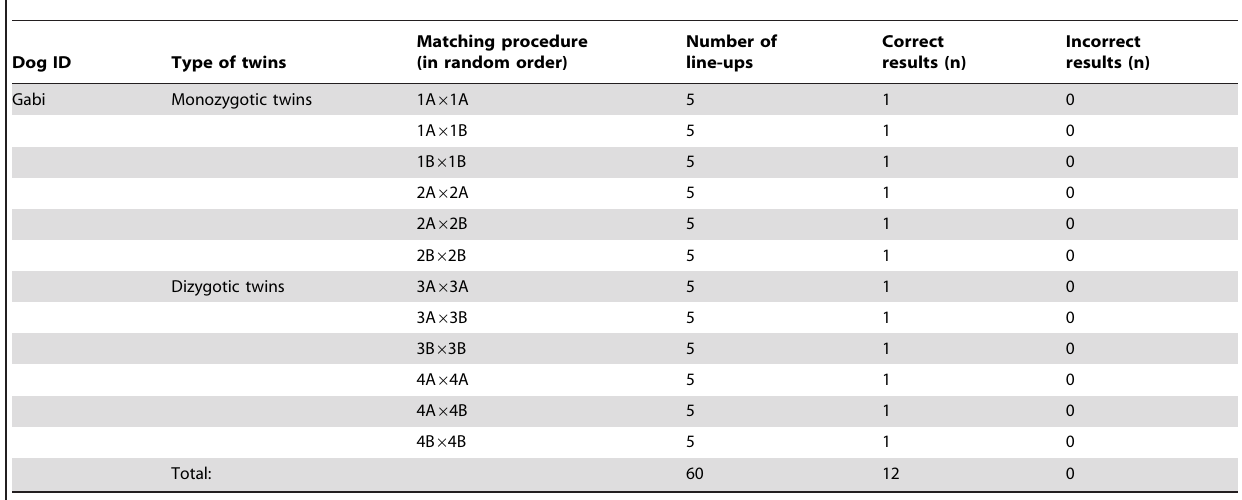
Table 1. Scent identification matching procedures performed by one